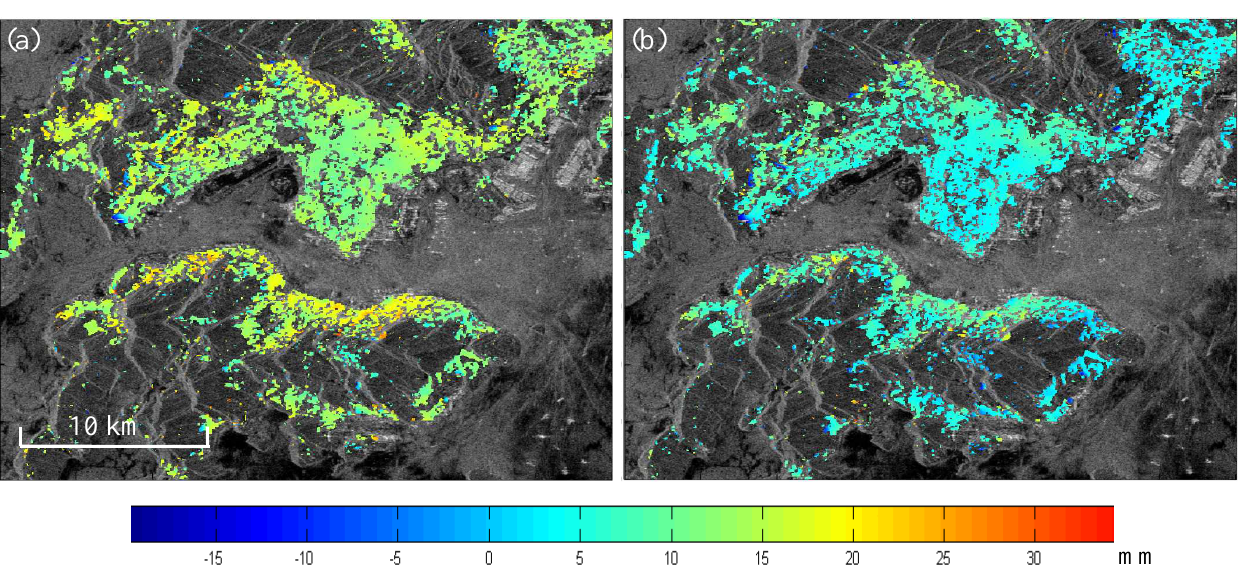
Figure 6. Atmospheric path delay correction for interferometric pair of 30 April 2006 and 11 March 2007 over Hong Kong area. (a) original interferogram; (b) interferogram corrected using MERIS